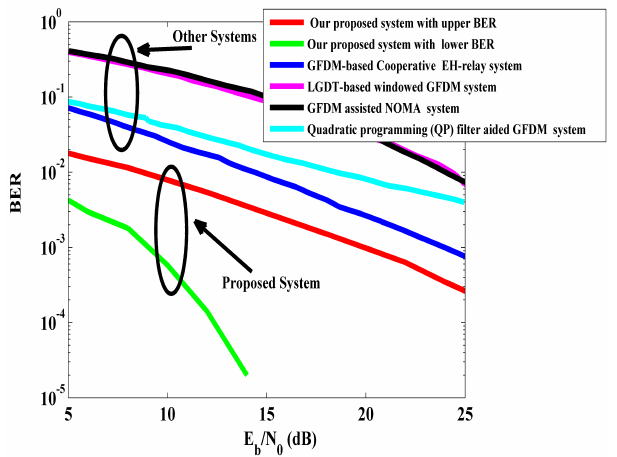
Figure 15. Comparative BER performance analysis between the proposed system and other B5G compatible multicarrier